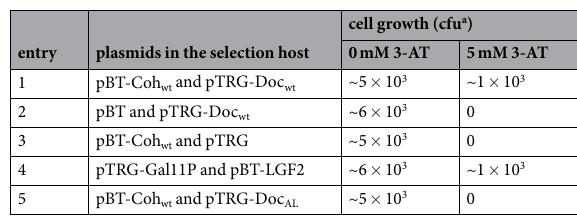
Table 1. Examination of Coh wt and Doc wt interaction using The BacterioMatch ® II two-hybrid system as the positive selection. a cfu, colony-forming